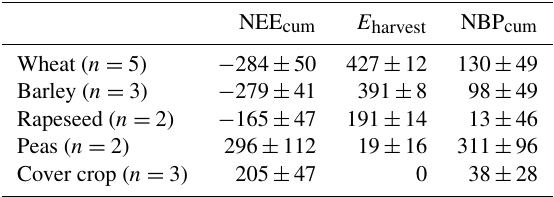
Table 2. Average and standard error of cumulative net ecosystem exchange (NEE cum ), C export through harvest ( E harvest ) and cu- mulative net biome production (NBP cum ) in gCm − 2 season − 2 of the five crop types with more than one season. The number ( n ) of seasons for each crop type is given in parentheses. Please note that cover crops were only grown during autumn and